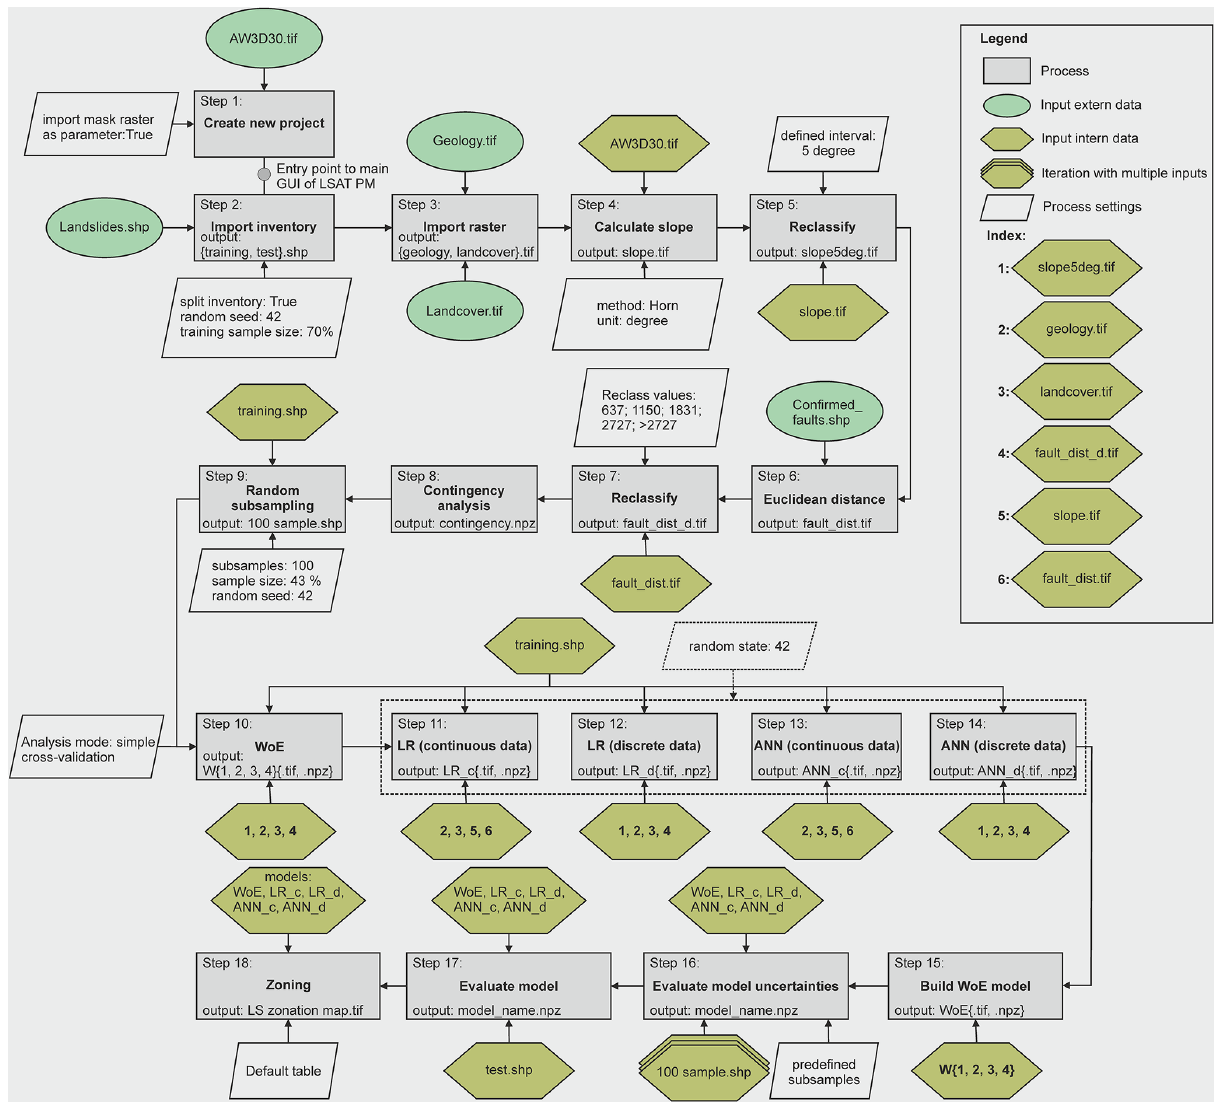
Figure 6. Workflow applied to the test